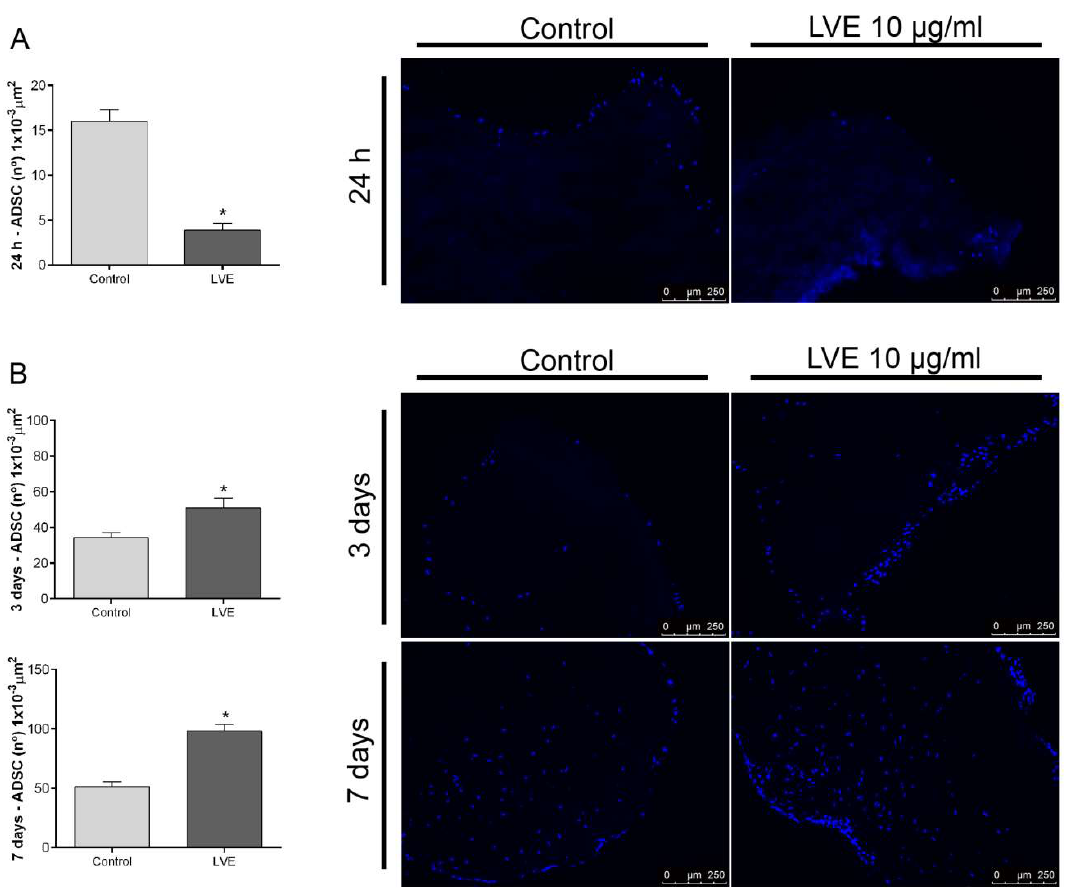
Figure 7. Extracellular vesicles derived from LVE affect scaffold recellularization. ( A ) Representative images and analysis of the number of cells/area of fragments previously coated with 10 µg/mL LVE-EVs and cultivated with ADSCs for 24 h. ( B ) Representative images and analysis of the number of cells/area of fragments cultivated with ADSCs for 24 h and then stimulated with 10 µg/mL LVE-EVs. The fragments were cultivated for 3 and 7 days. Unpaired t test * p < 0.05.